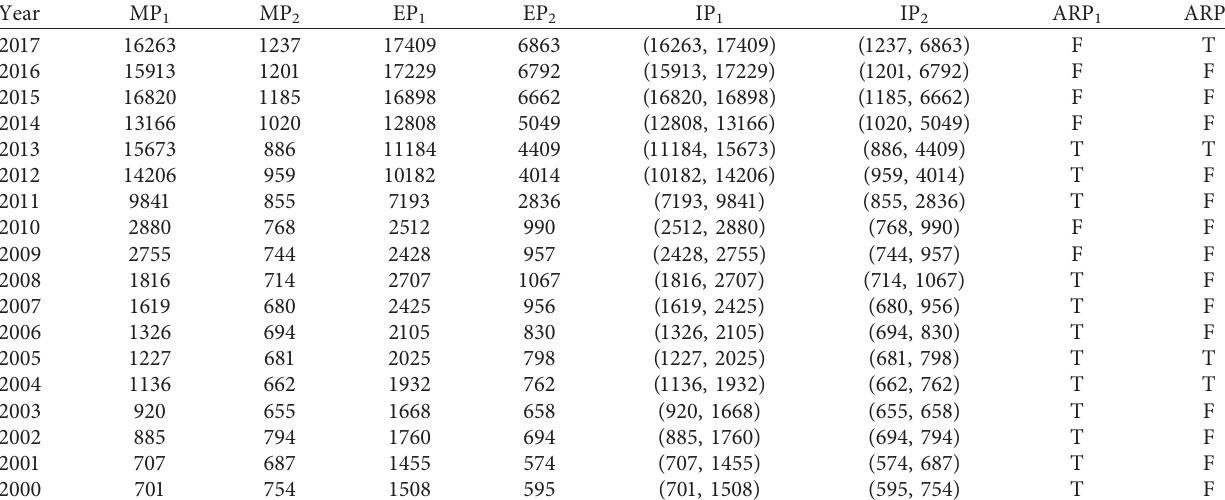
Table 2: Solution and scale suitability interval of MCGP model.